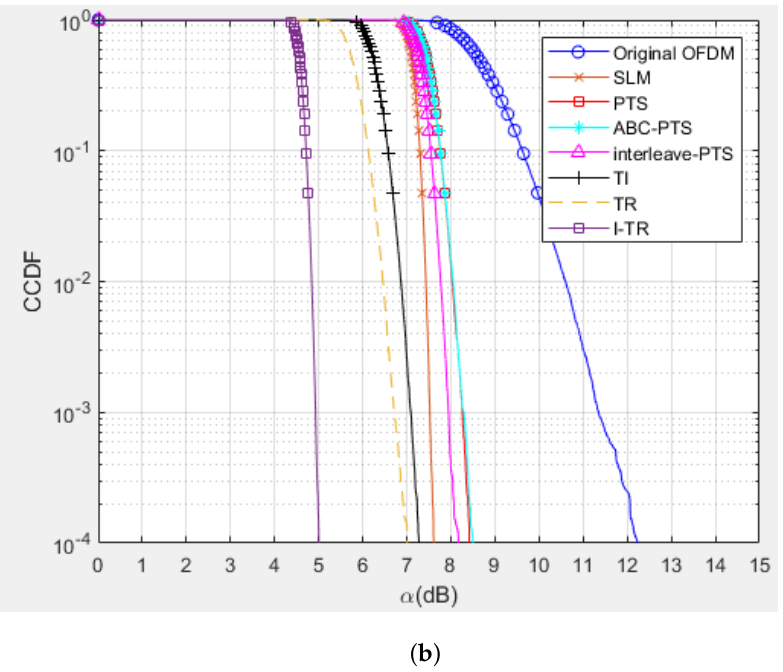
Figure 9. The PAPR performance of SLM [18], PTS [21], ABC–PTS [22], interleave–PTS [23], TI [27], TR [28], and I–TR for 16–QAM ( a ) N = 512 and ( b ) N = 1024.